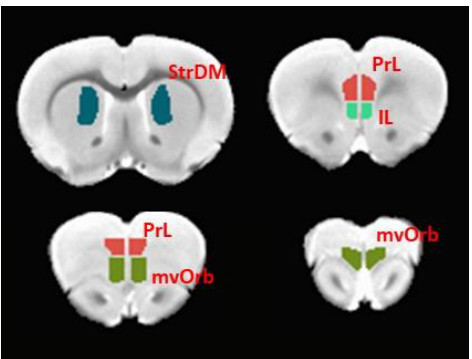
Figure 1. Demonstration of regions of interest for resting state functional MRI (rs-fMRI) data analysis. IL: infralimbic cortex; PrL: prelimbic cortex; mvOrb: medial-ventral orbitofrontal cortex; StrDM: dorsomedial striatum.